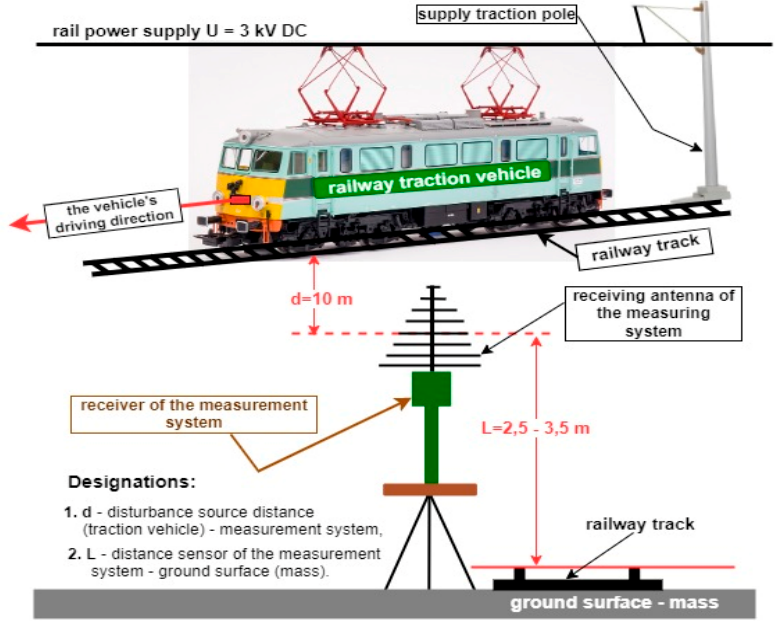
Figure 7. Measurement of radiated interference emission in the 230 MHz ÷ 1 GHz frequency band using a log-periodic antenna.